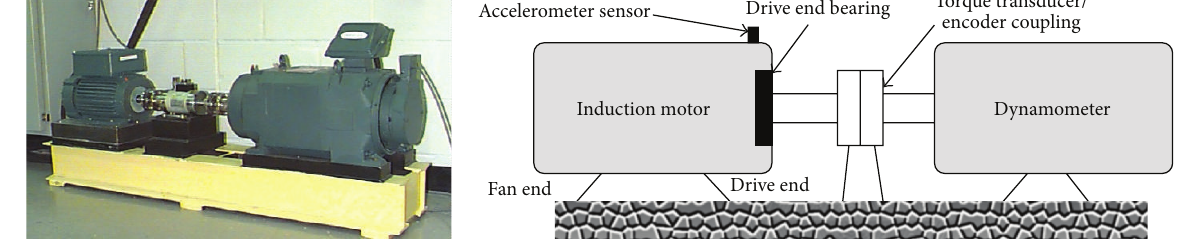
(b) Schematic diagram of the experimental setup Figure 4: Experimental